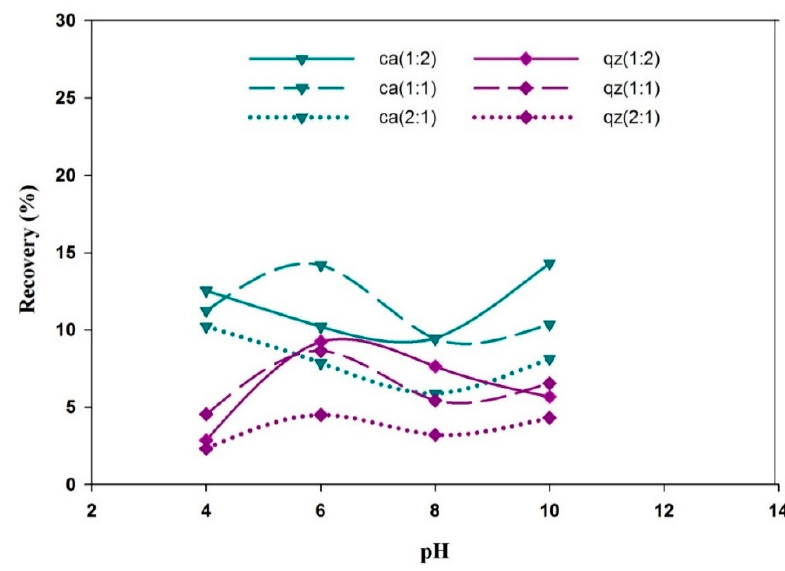
Figure 6. Hallimond flotation recovery of gangue minerals in presence of collector blend as a function of pH at collector concentration 3 × 10 − 5 M. ca-calcite, qz-quartz.